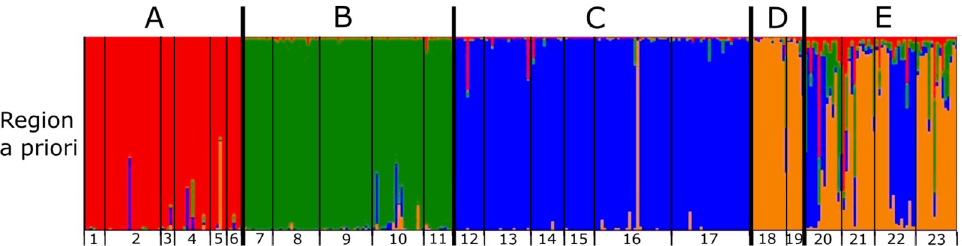
Fig 3. Plot of genetic STRUCTURE results. Individuals (vertical bars) are grouped by site (1–23) and region (A–E; separated by bold vertical lines; see Fig 1). Results are presented for the most likely number of genetic clusters, K = 4 when conditioning on region (see S2 Fig for runs with alternative